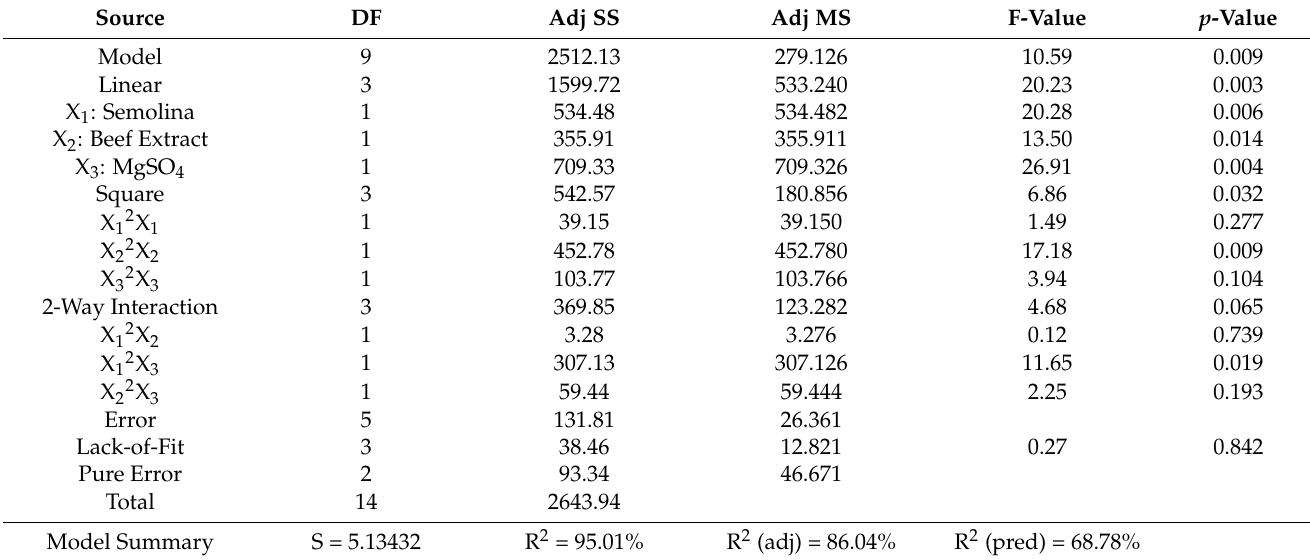
Table 2. Analysis of variance of antifungal activity against C. arachidichola .